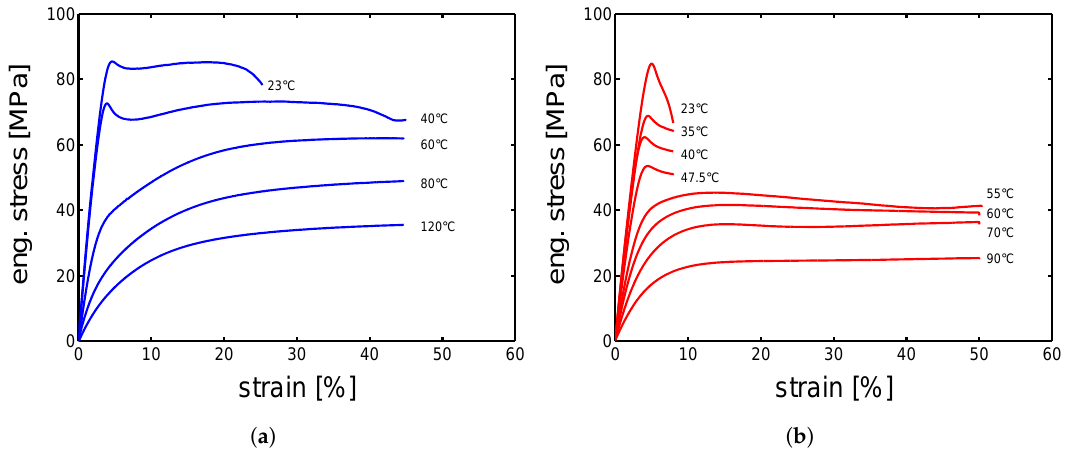
Figure 8. Stress-strain response at temperatures in a range from 23 to 120 °C, and strain rate of 10 − 2 s − 1 for ( a ) α -I and ( b ) γ -I